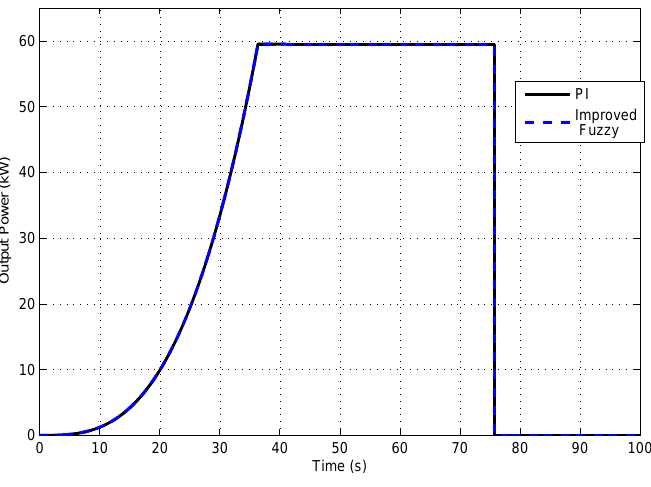
Figure 13. Pitch angle variation.